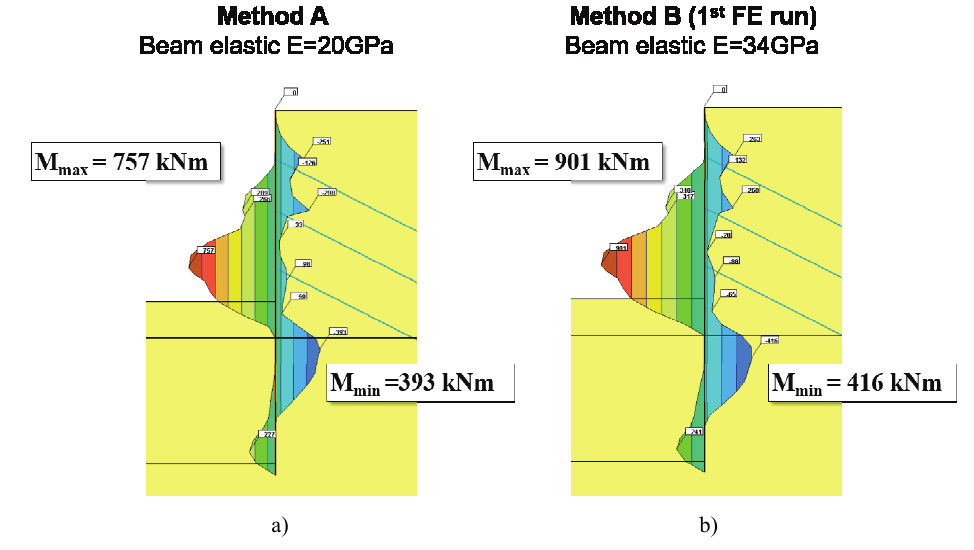
Fig. 7. Comparison of the computed envelopes for bending moments in the retaining wall: (a) Method A – elastic beam elements defined by E = 20 GPa, (b) 1st analysis for Method B assuming elastic beam defined by a nominal Young’s modulus E = 34